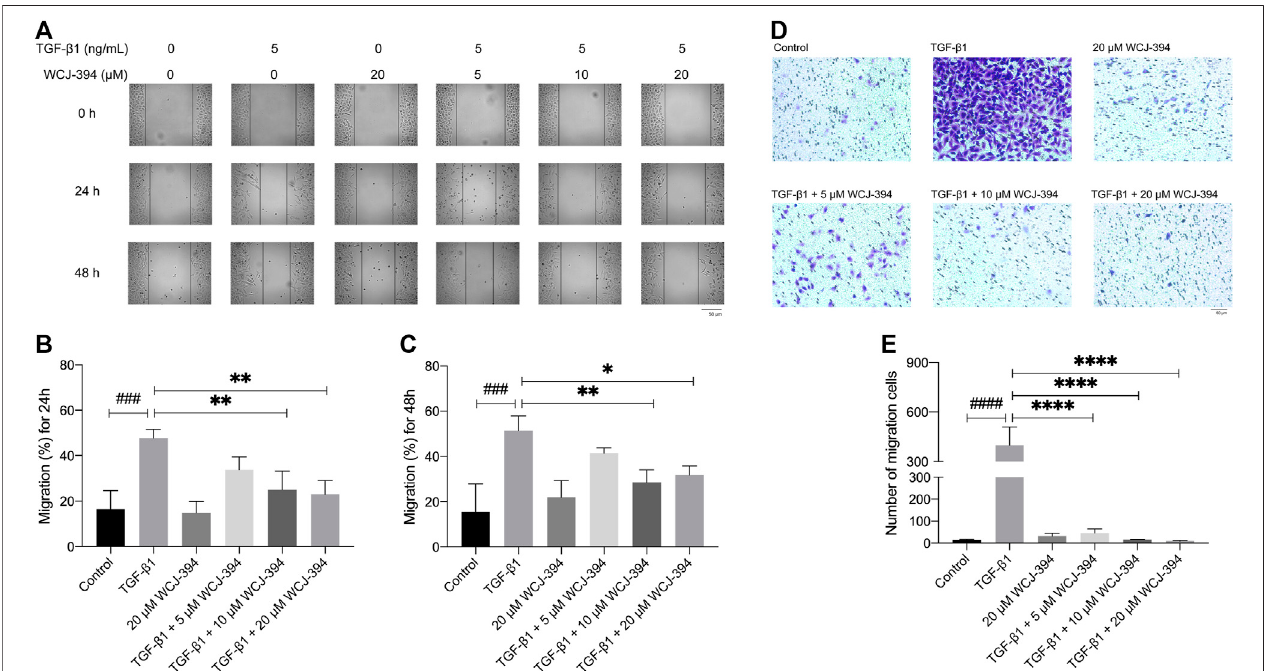
FIGURE 6 | WCJ-394 inhibited the TGF- β 1-induced cell migration in A549 cells. (A) Effects of WCJ-394 on the TGF- β 1-induced A549 cell migration in a scratch wound healing-based migration assay. (B) The scratched wound closure of A549 cells at 24 h in the scratch wound healing assay. (C) The scratched wound closure of A549 cells at 48 h in the scratch wound healing assay. (D) Effect of WCJ-394 on the TGF- β 1-induced A549 cell migration in a transwell-based migration assay. (E) Numbersofmigration cellsfromdifferentgroupsin thetranswell assay. ### p < 0.001, #### p < 0.0001vs. thecontrol group;* p < 0.05, ** p < 0.01,**** p < 0.0001vs. the TGF- β 1